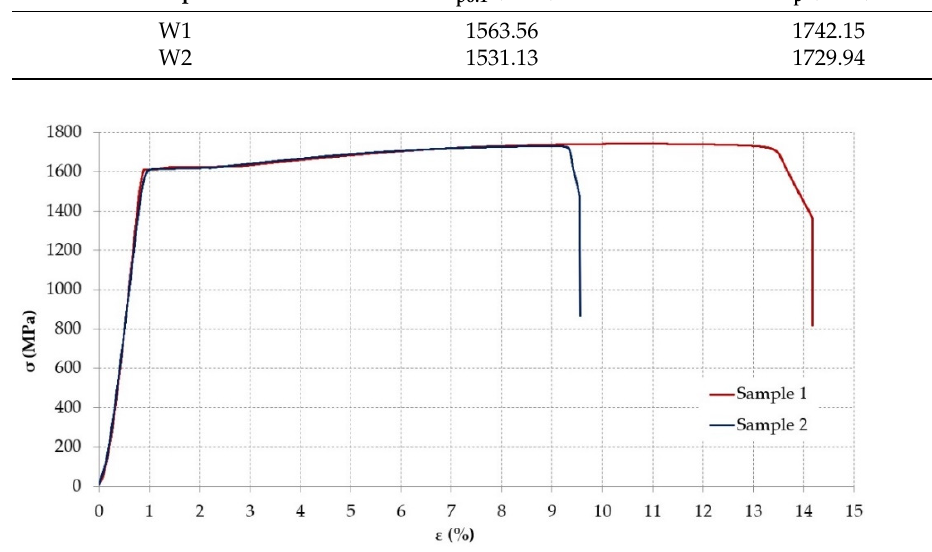
Figure 6. Stress–strain curve of tested samples of prestressing wires.